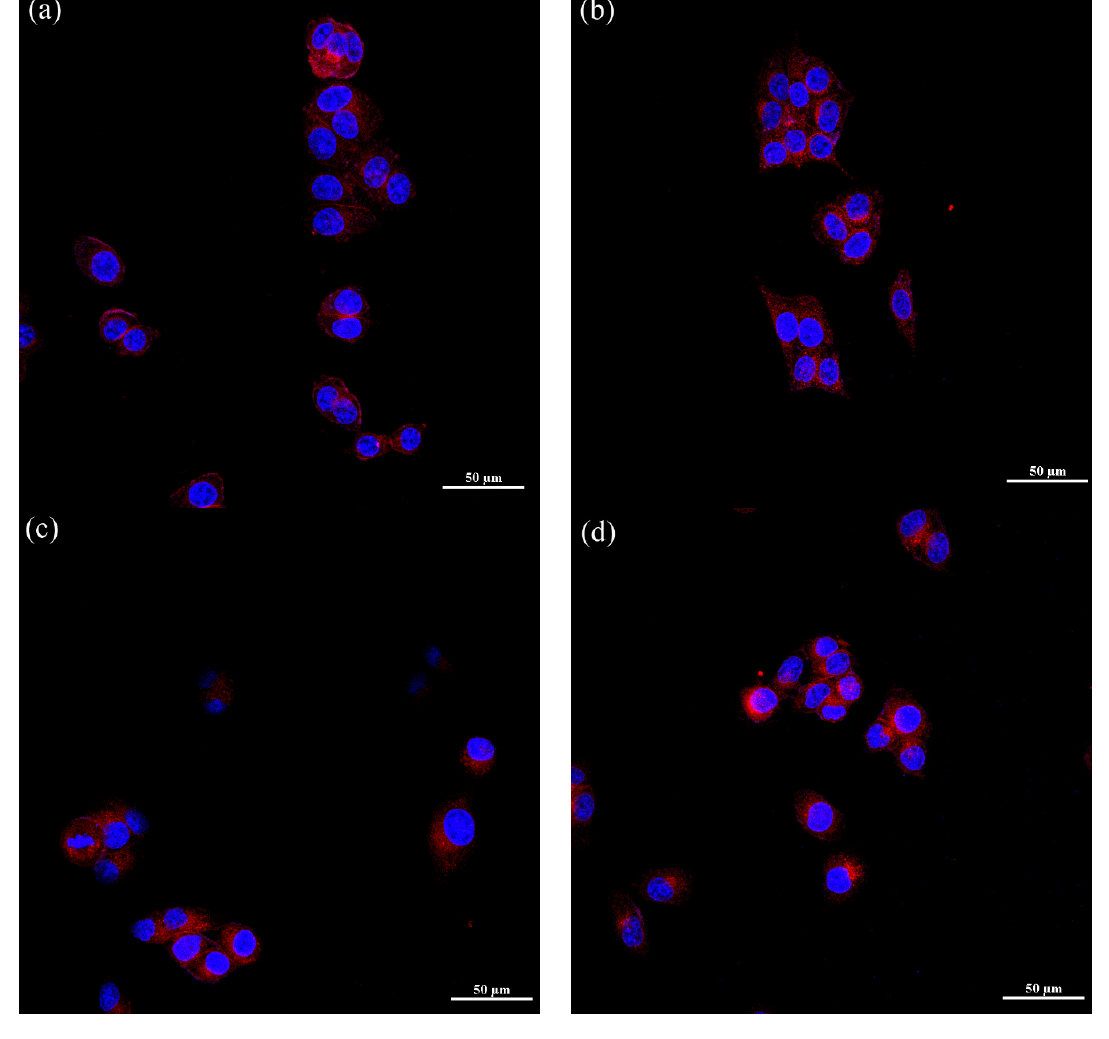
Figure 6. Confocal laser images of MCF-7 cells incubated with ( a ) DOX-4SPCL-PEG micelle; ( b ) DOX-4SPCL-PEG-Folic micelle; ( c ) KB cells incubated with DOX-4SPCL-PEG micelle; and ( d ) DOX-4SPCL-PEG-Folic micelle for 3 h with DOX concentration of 5 μ g/mL (scale bar 50 μ